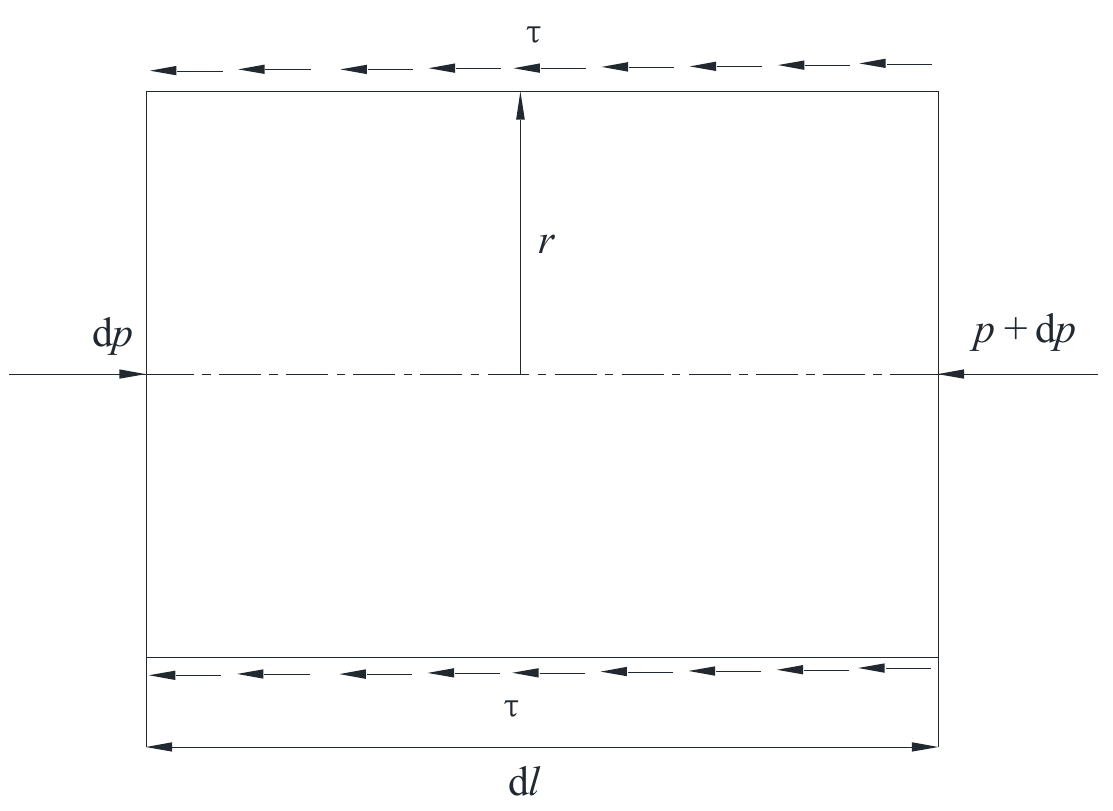
Figure 1. Flow diagram of a Newtonian fluid with time-dependent behavior in a circular tube. Equation (6) is integrated by the method of separation of variables, and the boundary conditions r = r 0 and v = 0 at the pipe wall are considered. In this way, the velocity equation of the time-varying Newtonian fluid moving in the cross-section of the pipe is obtained